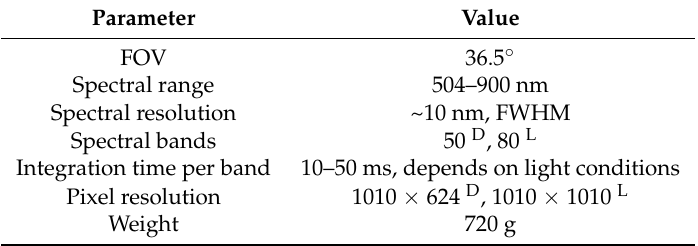
Table 2. Technical setting of the Rikola camera, as used in the field and